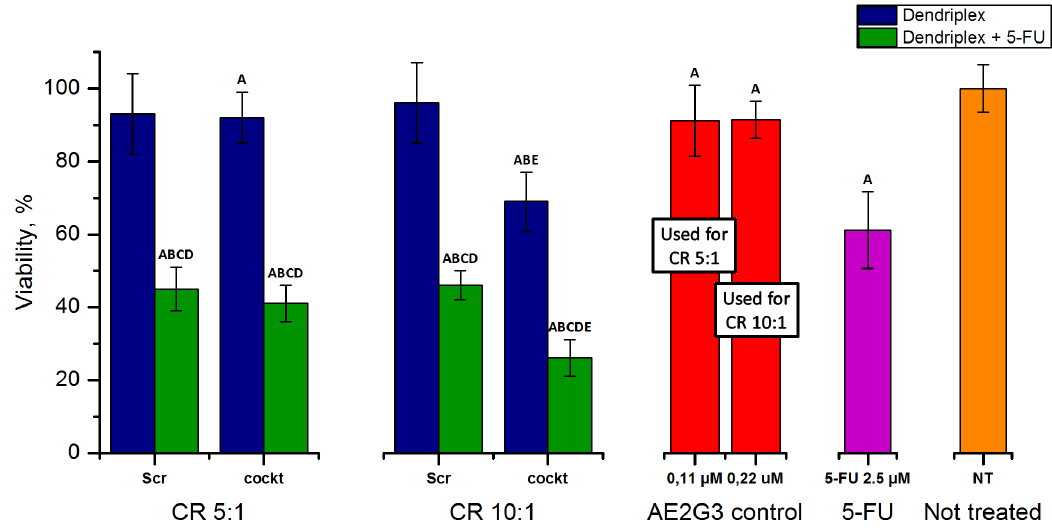
Figure 7. Differences in the viability of HeLa cells exposed to AE2G3/pro-apoptotic siRNAs dendriplexes formed at dendrimer/siRNA charge ratios of 5:1 and 10:1 with 25 nM siRNA in combination with 2.5 µM 5-FU. A—significant difference to untreated cells (Dunnett test), p < 0.001. B—significant difference to relevant concentration of dendrimer, used to form dendriplex (Dunnett test), p < 0.001. C—significant difference to 2.5 µM 5-FU (Dunnett test), p < 0.001. D—significant difference to relevant dendriplex w/o 5-FU ( t -test), p < 0.001. E—significant difference to relevant dendriplex formed at CR 5:1 ( t -test), p < 0.001. Data are presented as Mean ± Standard Deviation. n of untreated control = 315, n of 5-FU group = 139, for all other groups— n was ranged from 18 to 36.